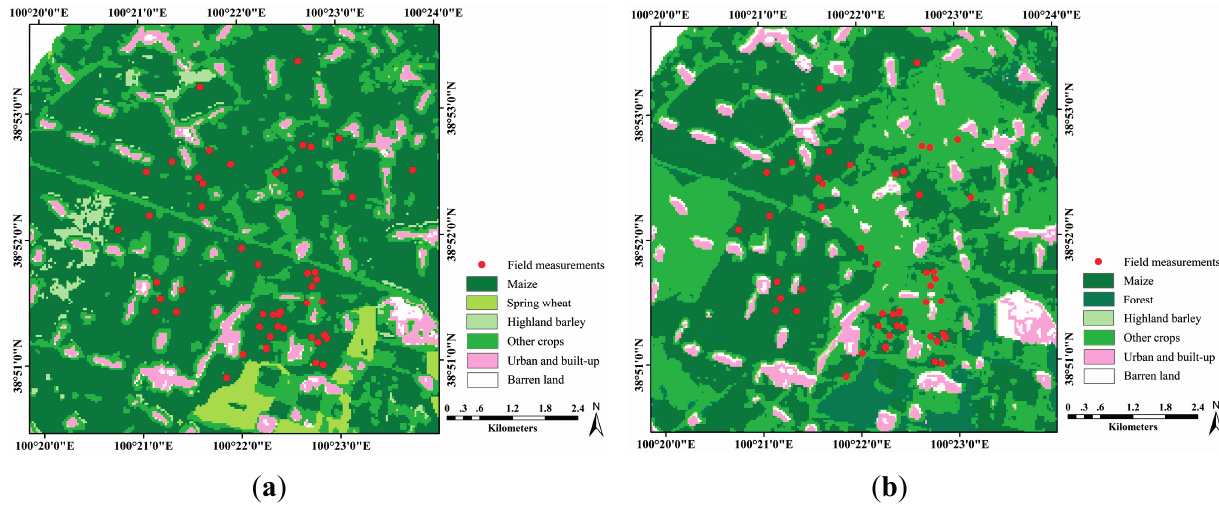
Figure 3. Land cover maps and the LAI field measurements of the study area in July 2012 ( a ) and July 2013 ( b ). The red point is the LAI field measurement, the green area is covered by corn crops, and the light green area is covered by other crops.